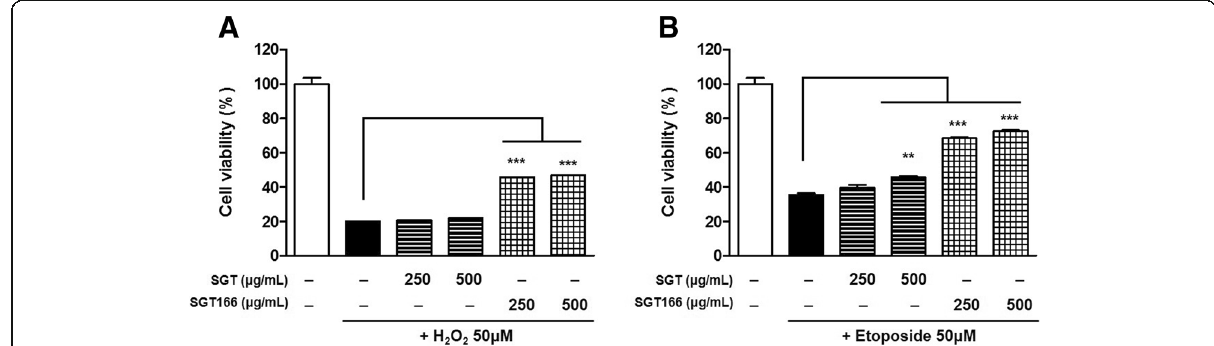
Fig. 4 Neuroprotective effect of SGT and SGT166 against toxicant-induced SH-SY5Y cell loss. Cells were pretreated with SGT or SGT166 for 6 h, and then separately exposed to 50 μ M H 2 O 2 ( a ) and 50 μ M etoposide ( b ) for 24 h. Cell viability was determined by CCK analysis and the results are expressed as the percentages of viable cells compared to the cells untreated with any toxicant. The values shown are means ± SE ( n = 5). ** P < 0.01 and *** P < 0.001 versus the cells treated with toxicant